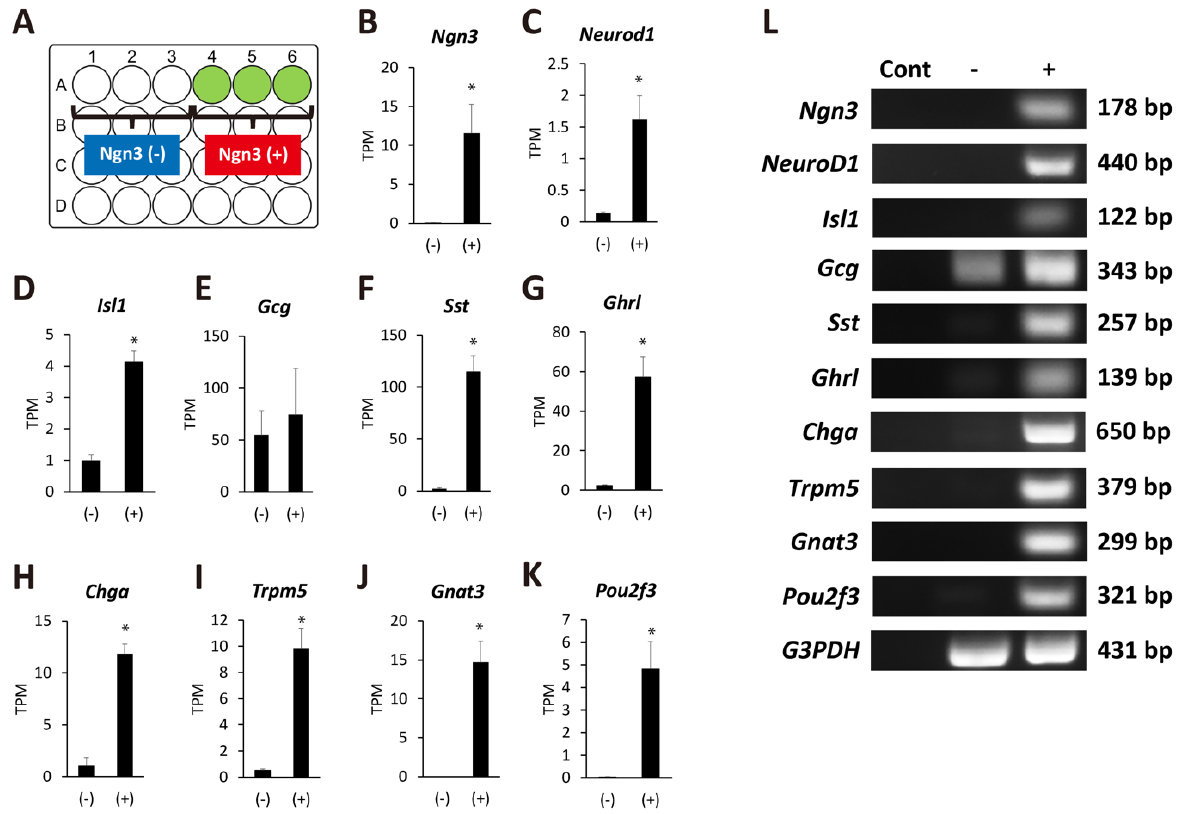
Figure 4. Ngn3-GFP-positive organoids show the potential to differentiate into several lineages. ( A ) Schematic presentation of the wells with or without organoids expressing GFP. Organoids were defined as Ngn3(+) if GFP-positive cells were observed on day 11. In contrast, organoids without GFP signal were defined as Ngn3( − ). ( B – K ) Transcriptome analysis was performed with total RNAs extracted from day 11 organoids that expressed either Ngn3( − ) and Ngn3(+) cells. Ngn3, NeuroD, and Isl1, key regulators of the endocrine lineage; mature endocrine markers Sst, Ghrl, and Ghga; and taste-related genes Trpm5, Gnat3, and Pou2f3, were significantly expressed in Ngn3-GFP-expressing organoids (n = 3, * q < 0.05). The gene Gcg, encoding GLP-1 and GLP-2, was expressed in both Ngn3( − ) and Ngn3(+) cells ( E ). Results of RNA-Seq analysis were confirmed by RT-PCR ( L ). Cont, negative control without cDNA .